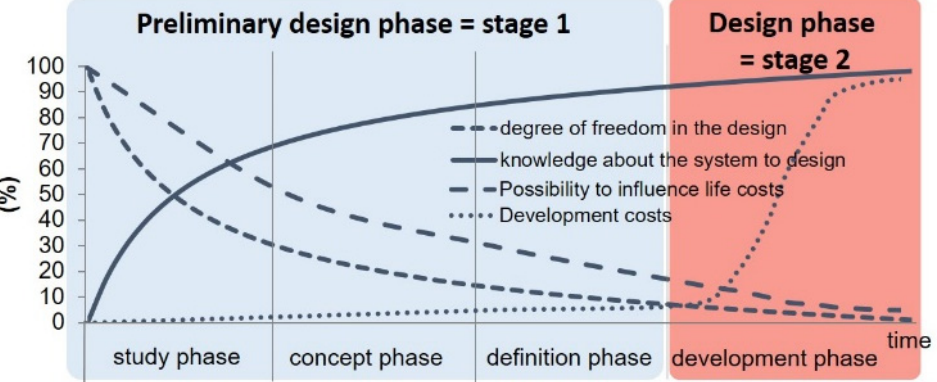
Figure 1. Design process paradox and timeline expenditure.